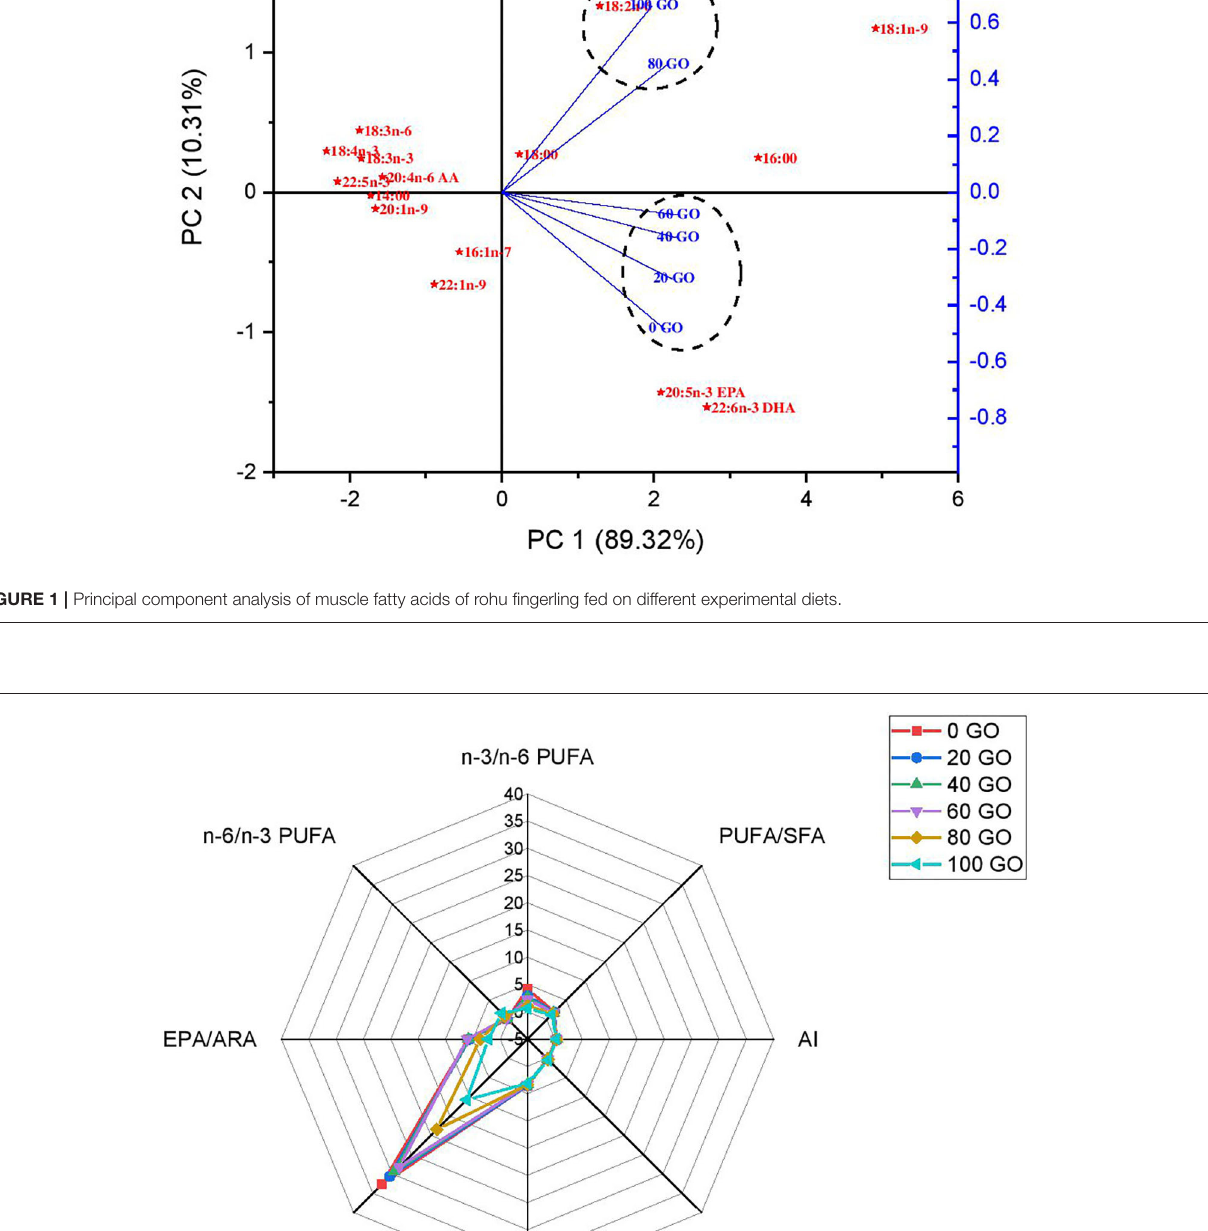
Frontiers in Sustainable Food Systems |